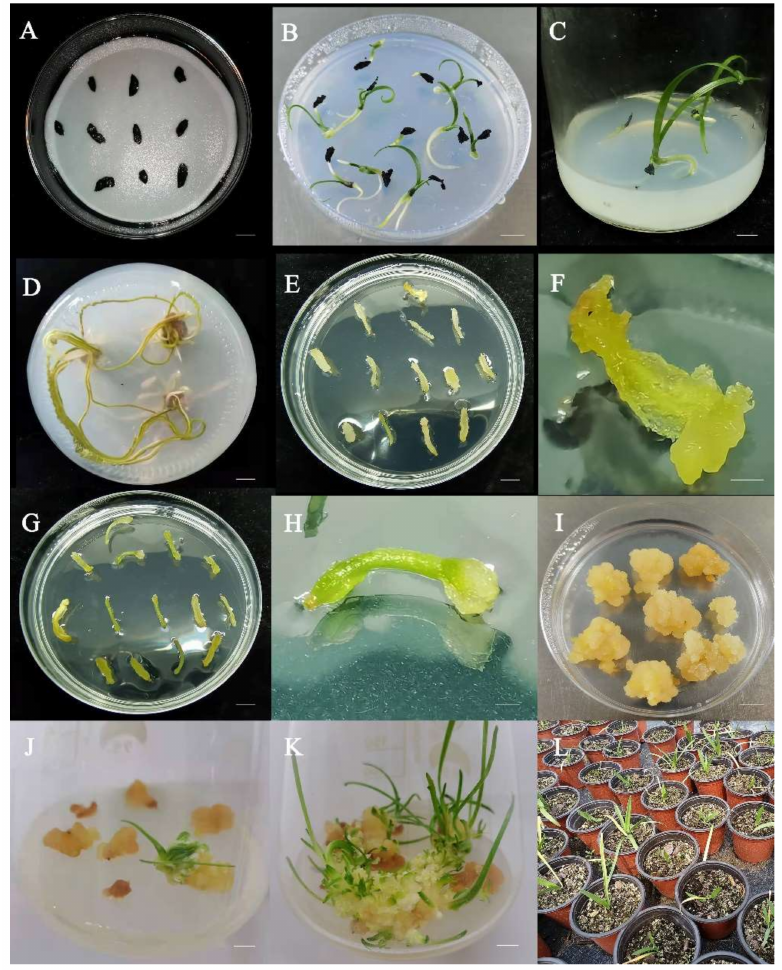
Figure 7. Indirect organogenesis tissue culture system of A. praecox root explants. ( A ) Germinated seeds after inoculation into MS medium; ( B , C ) Seedlings after germination for 20 days ( B )